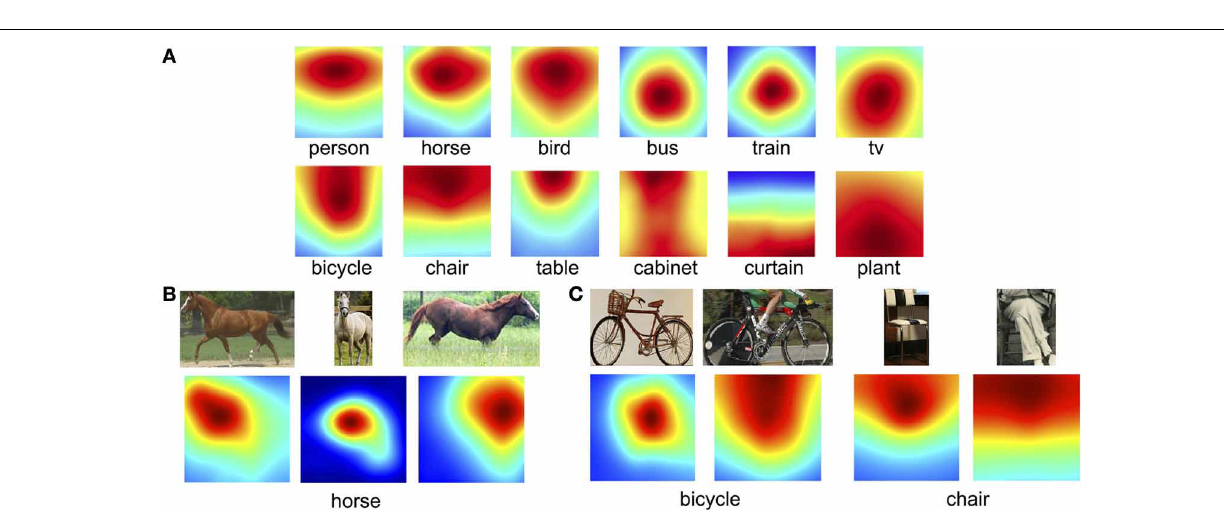
(C) A bias to fixate the tops of bicycles was driven by cases showing a rider, but the tops of chairs and tables were fixated regardless of the depiction of a